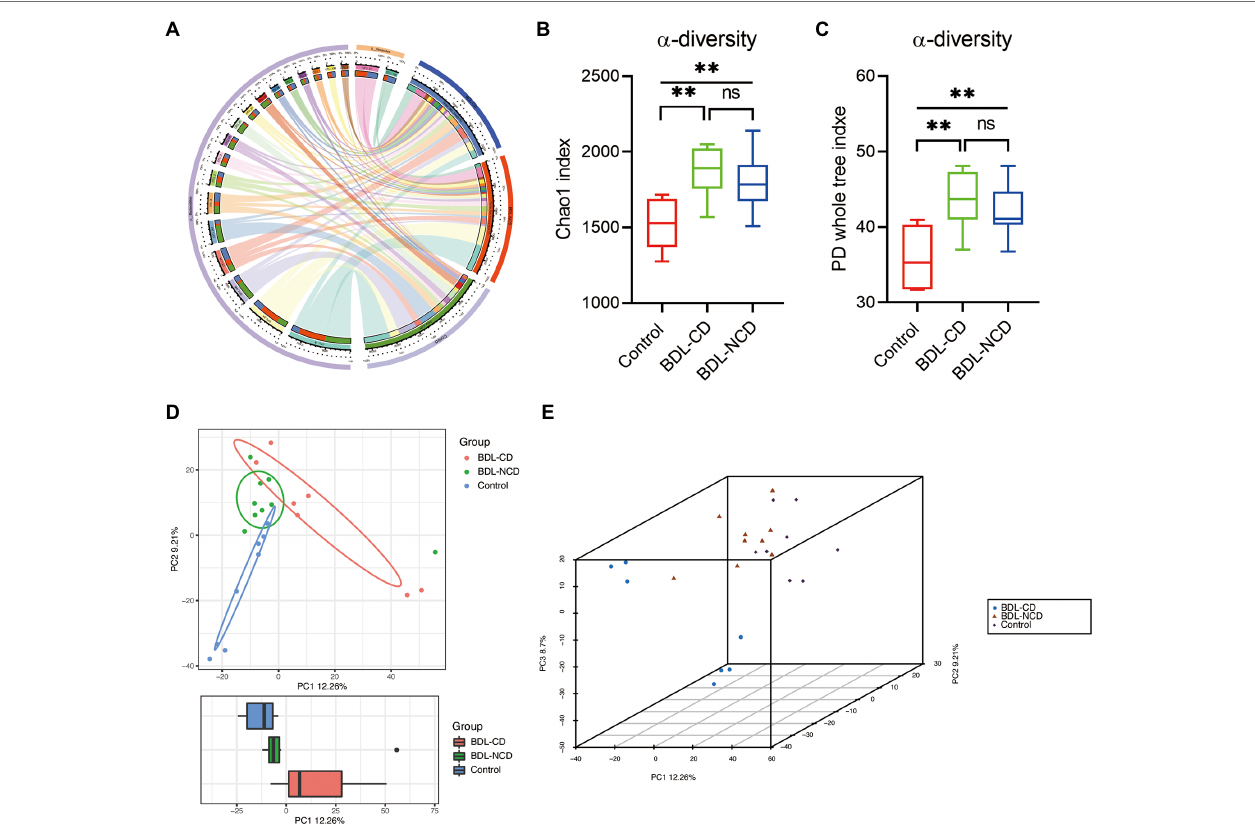
FIGURE 3 | Community structure and diversity alteration in gut microbiota among the three groups. (A) Circos plot showing the different community structures among the three groups. (B) α -diversity Chao1 index [ F (2,21) = 8.910, p = 0.0016]. (C) α -diversity PD whole tree index [ F (2,21) = 9.043, p = 0.0015]. (D) Boxplot of PCA. (E) 3D plot of PCA. Data are presented as the mean ± SEM. ** p < 0.01; ns, not